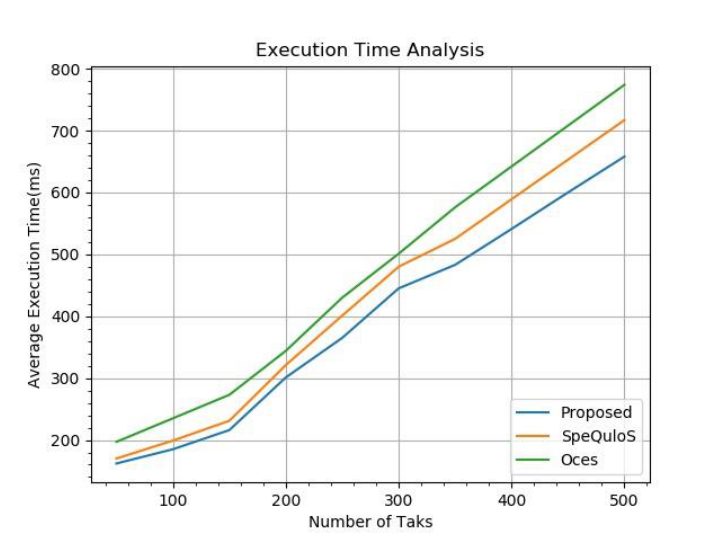
Figure 2. Execution Time Analysis of proposed work